Question: Summarize what this figure shows in one sentence.
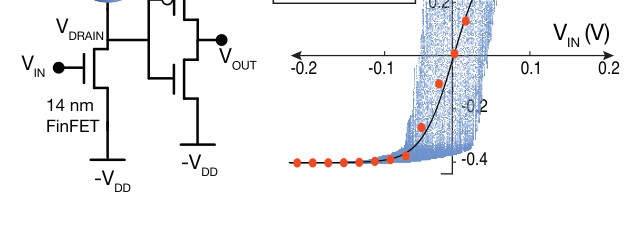
Answer: 3T/1MTJ p-bit circuit with double-SAF-free MTJ (a) We use the full circuit model described in FIG. 2in conjunction with a 14 nm HP-FinFET predictive model [65], simulated in HSPICE. Magnet diameters are 25 nm and thick- nesses are 1 nm. The diameter is chosen to match transistor resistance. (b) The blue trace is observed by observing VOUT as a function of VIN while VIN is linearly swept from −0.2 V to 0.2 V in a 250 ns time-window. The red dots are obtained as separate measurements where VIN is fixed to a given value and a time-average of the output over 5 µs is taken with a 1 ps time step. The black line is a tanh fit to this average.